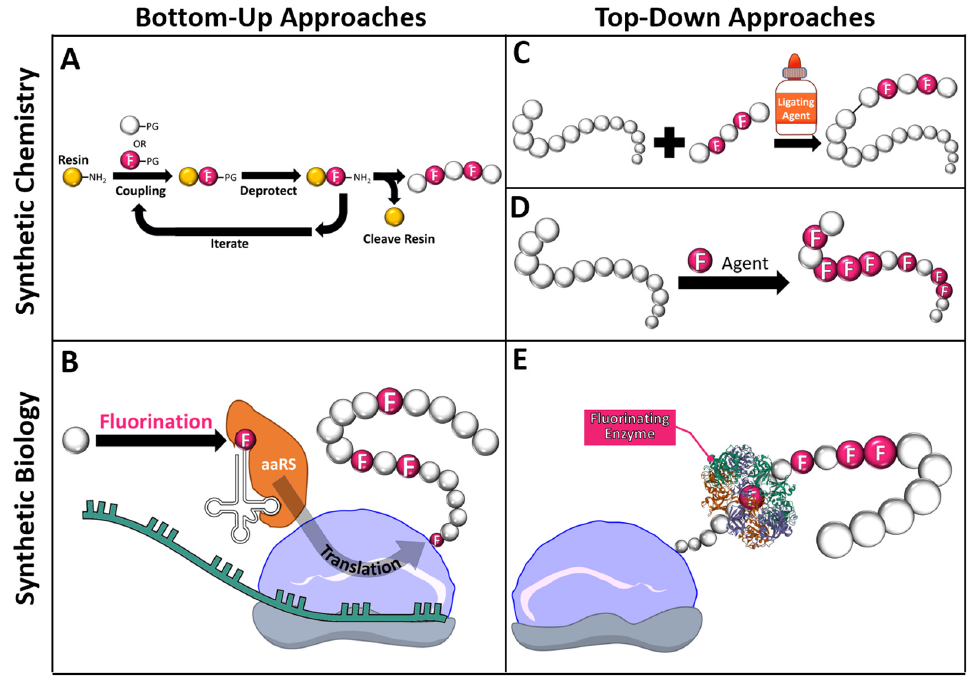
Figure 2. Bottom-up and top-down approaches utilizing various synthetic chemistry and synthetic biology techniques to install fluorine into proteins. Illustrations depicting the generalized process of: ( A ) solid phase peptide synthesis; ( B ) biosynthetic non-canonical amino acid incorporation; ( C ) protein fragment ligation; ( D ) bulk protein fluorination and ( E ) post-translational enzymatic modifications with fluorine. White spheres symbolize building blocks, whereas spheres highlighted in fuchsia and labelled with F represent fluorinated variants. PG signifies protecting group and aaRS indicates aminoacyl tRNA synthetase.